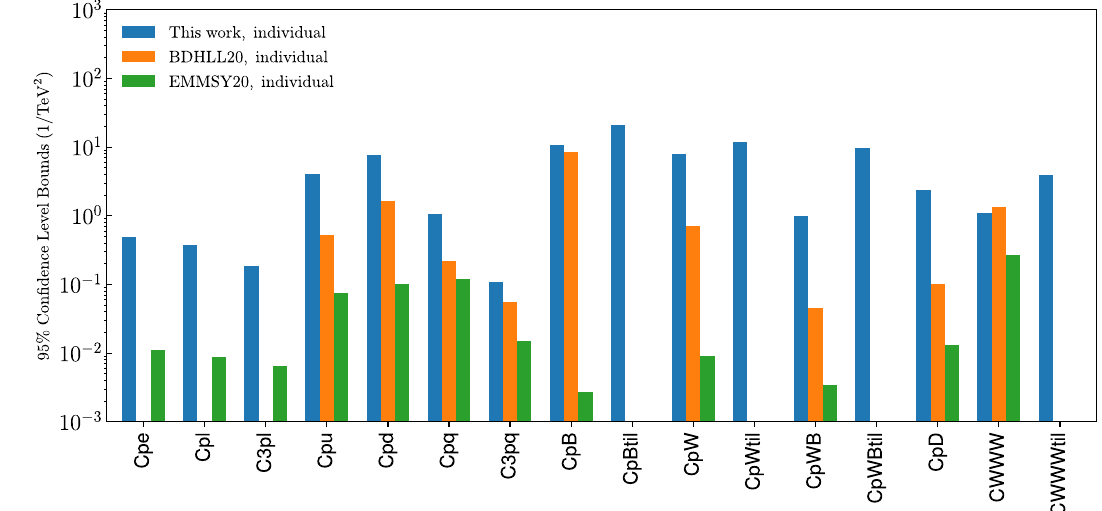
Fig. 23 Comparison of the individual bounds obtained in this work from the VBS+diboson dataset (shown in Fig. 20) with the cor- responding individual bounds obtained in the BDHLL20 [48] and